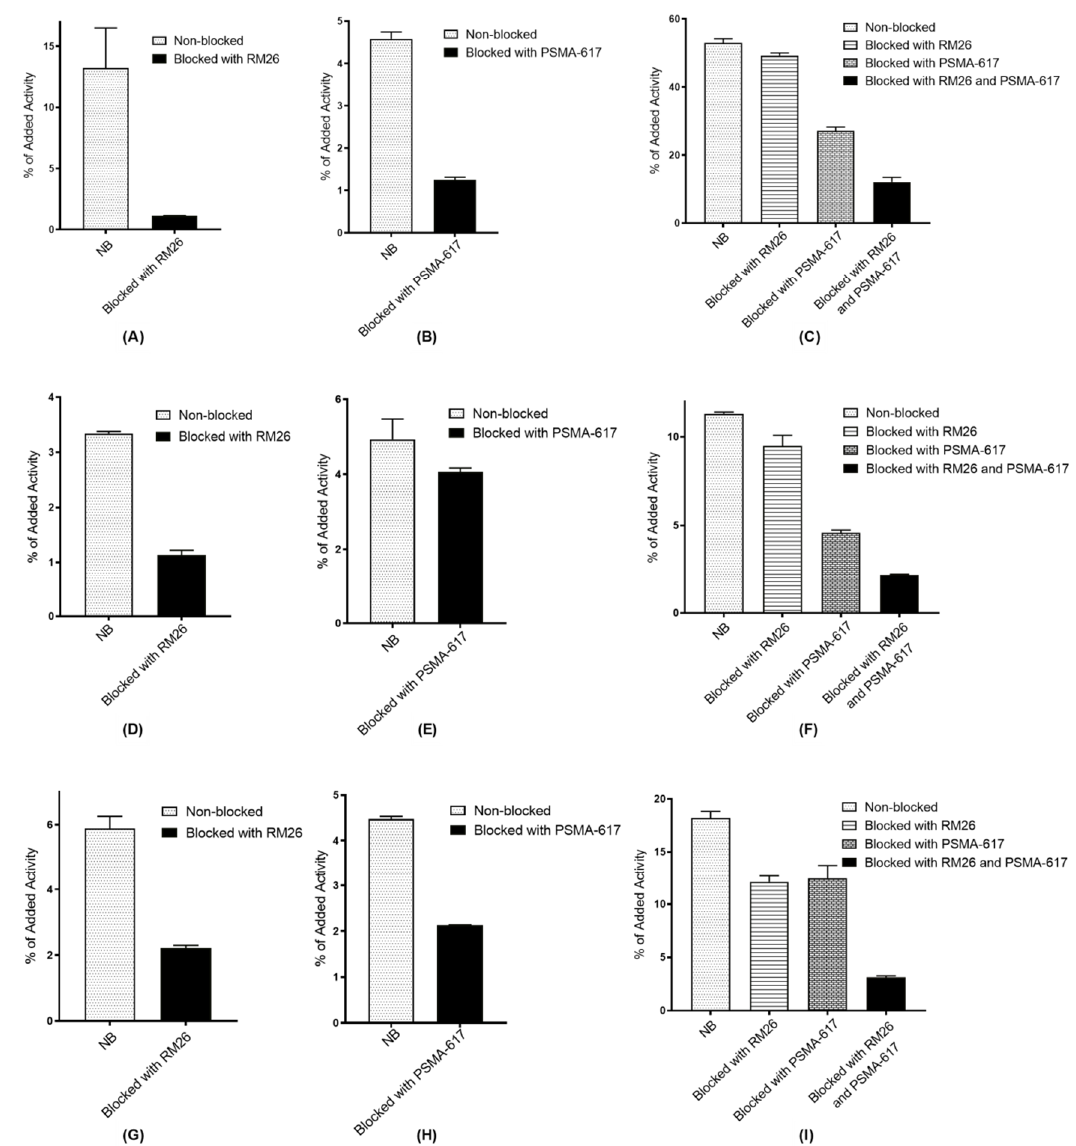
Figure 3. In vitro specificity test for [ 125 I]I-BO530 ( A – C ), [ 125 I]I-BO535 ( D – F ), and [ 125 I]I-BO536 ( G – I ). GRPR in the blocked group were pre-saturated by addition of 200-fold molar excess of non-labeled RM26, PSMA in the blocked group were pre-saturated by addition of 200-fold molar excess of non-labeled PSMA-617. Data are presented as average ± standard deviation.